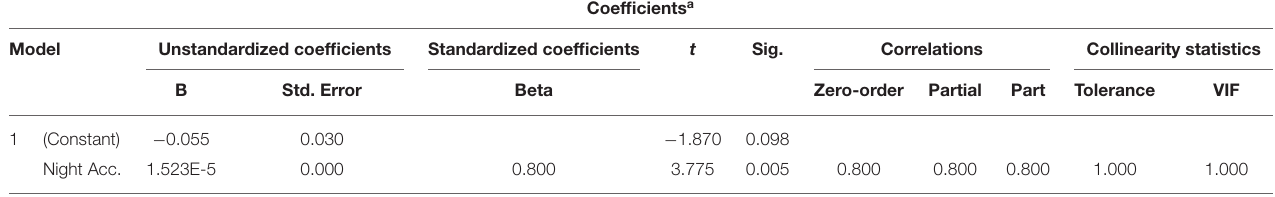
TABLE 7 | Pedestrian fatalities/1,000 regression